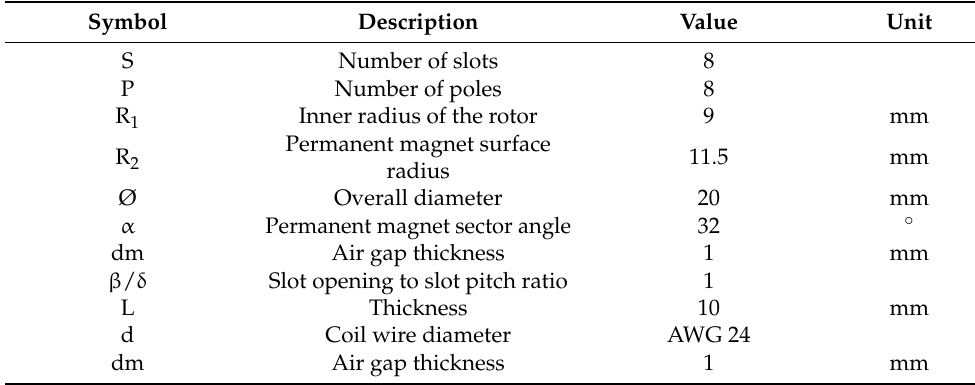
Table 3. Parameters of electromagnetic generator.